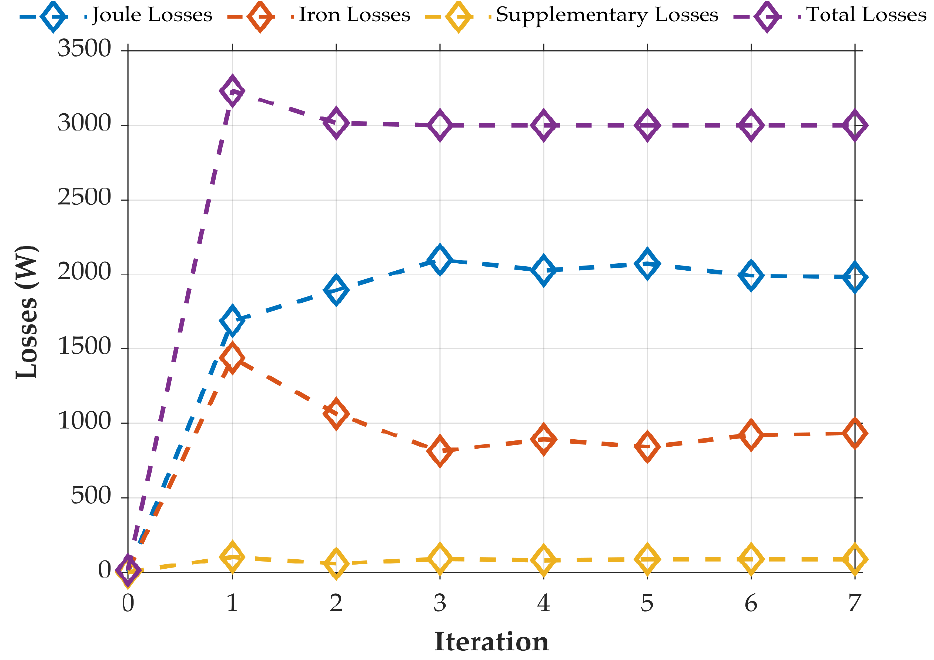
Figure 8. Machine Figure 8. Machine losses.